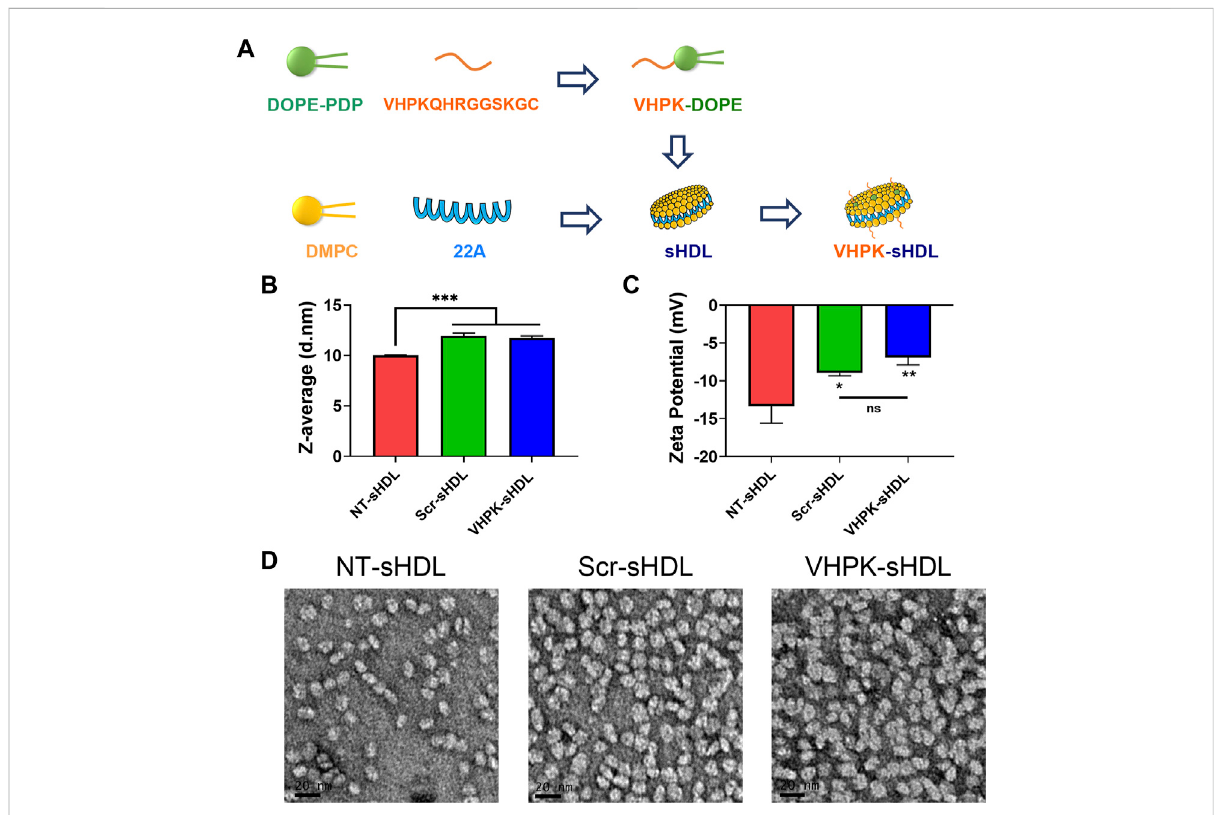
FIGURE 1 (A) SchematicillustrationofpreparationprocessofVHPK-sHDLs.Particlesize (B) andzetapotential (C) ofdifferentsHDLsmeasuredbyDLS( n = 3, mean ± SD). (D) Representative TEM images of different sHDLs. Scale bar represents 20 μ m * p < 0.05, ** p < 0.01, *** p < 0.05.